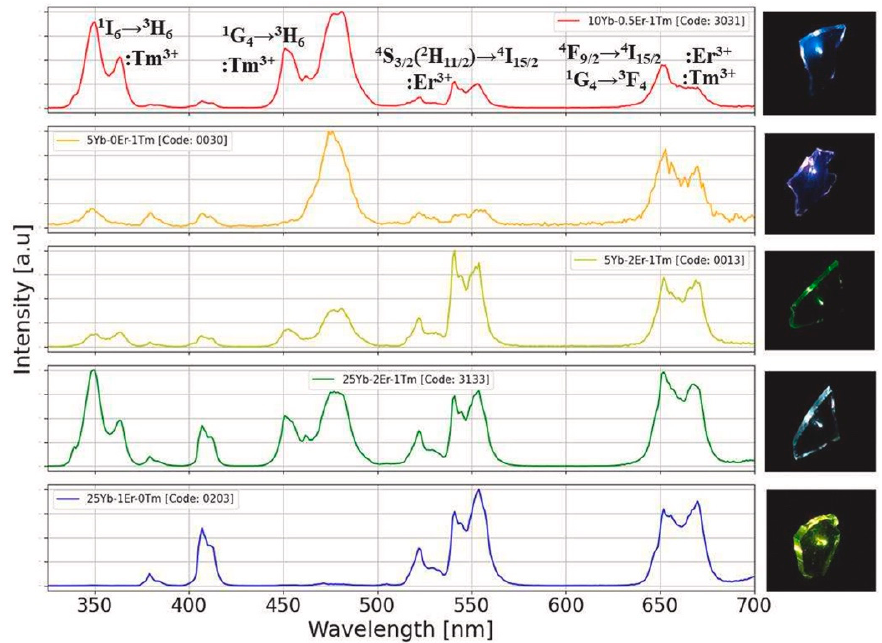
Figure 2. UV–VIS emission spectra by excitation at 980 nm of nano-glass-ceramics with composition 95SiO 2 –5NaYF 4 and different co-doping concentrations of Yb, Er and Tm ions. The corresponding images of upconversion light from the sol–gel samples are shown in the right-hand column. The upper plot also indicates the electronic transitions of rare-earth ions giving rise to the main upconversion emission bands. Reproduced from [29] under a Creative Commons